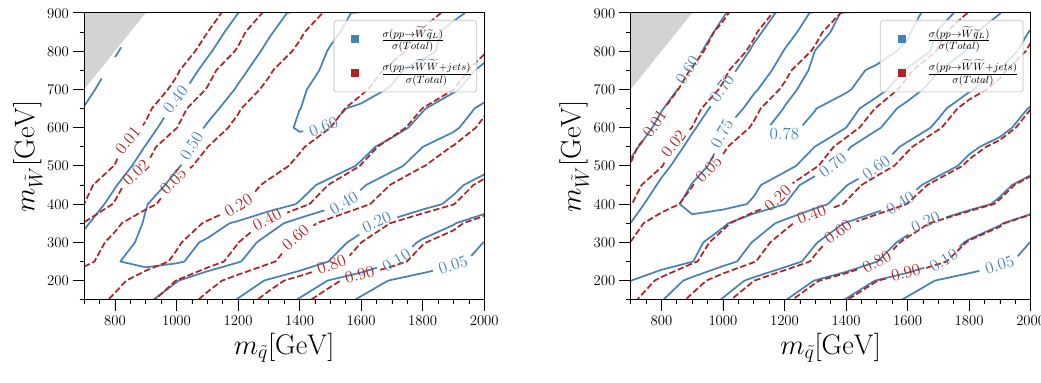
W and pp ˜ q L ˜ q ˜ q ∗ processes. The left and right → → f